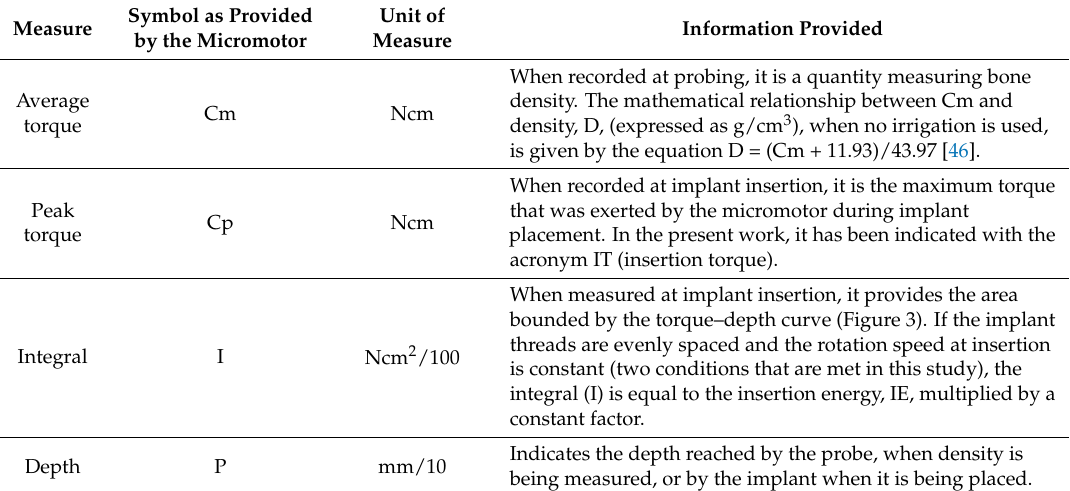
Table 2. A summary of the measures provided by the micromotor.